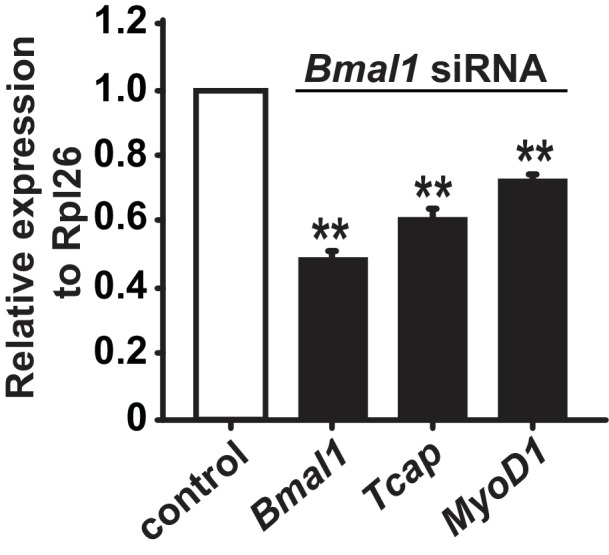
Effect of Bmal1 siRNA mediated knockdown on MyoD1 and Tcap expression.Relative mRNA expression levels for Bmal1, Tcap, and MYOD1 in C2C12 myotubes transfected with either Bmal1 siRNA (black bars) or a control non-targeting siRNA-A vector (white bar). Results are displayed as average fold-change relative to the control siRNA-A ± SEM (n = 4 biological replicates). Results were analyzed with one-way ANOVA, ** indicates a p-value less than 0.001.